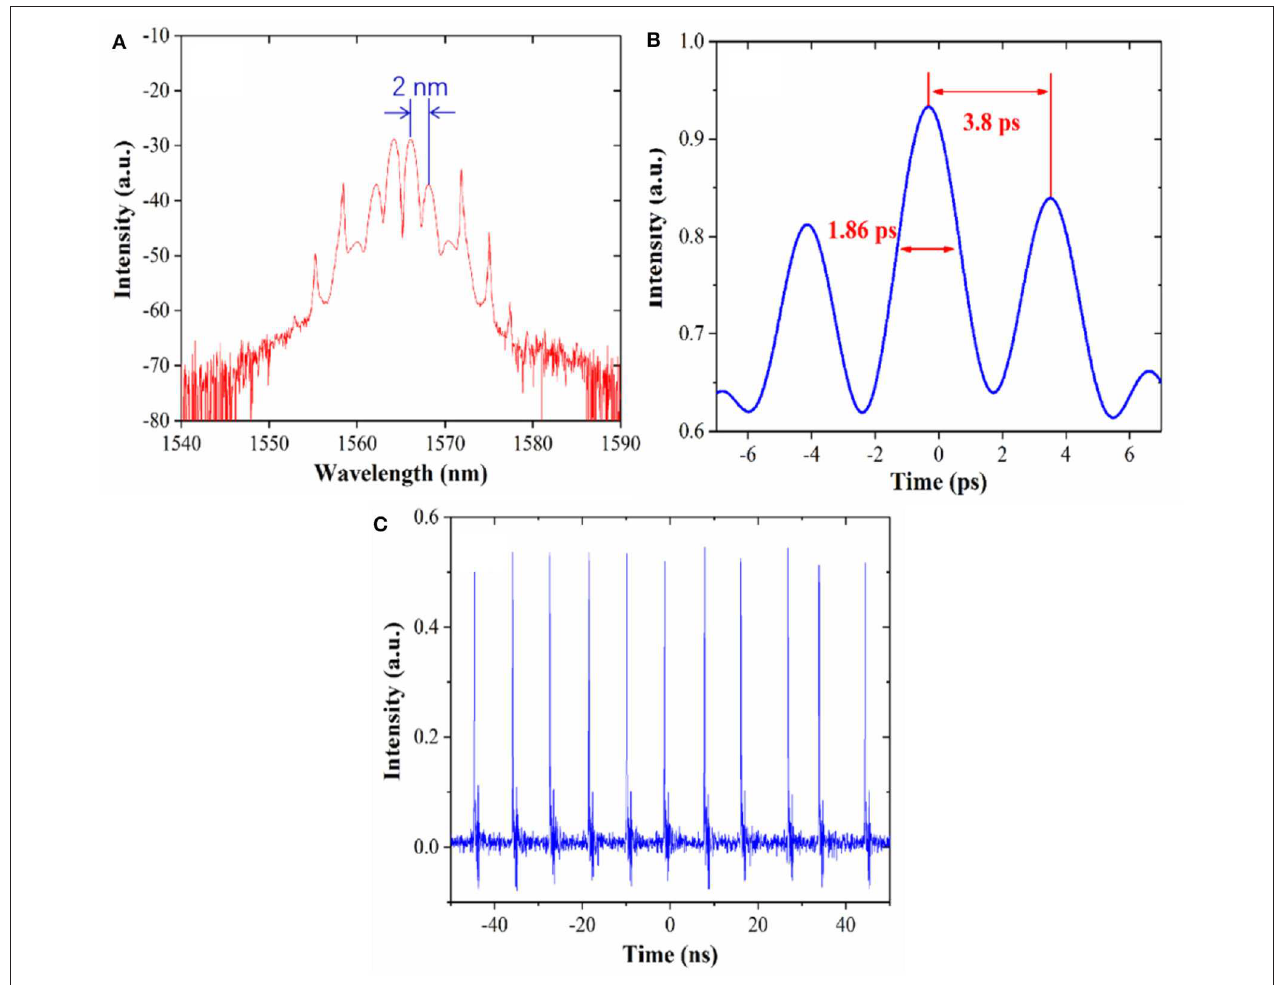
FIGURE 6 | (A) Output spectrum; (B) autocorrelation trace; (C) pulse